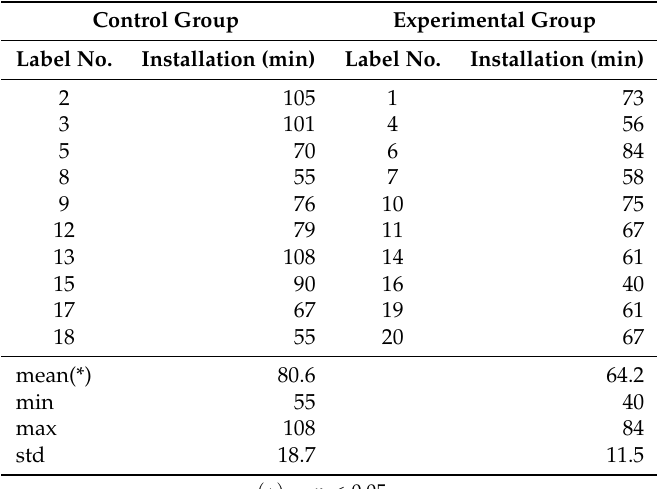
Table 3. Comparison of time spent in